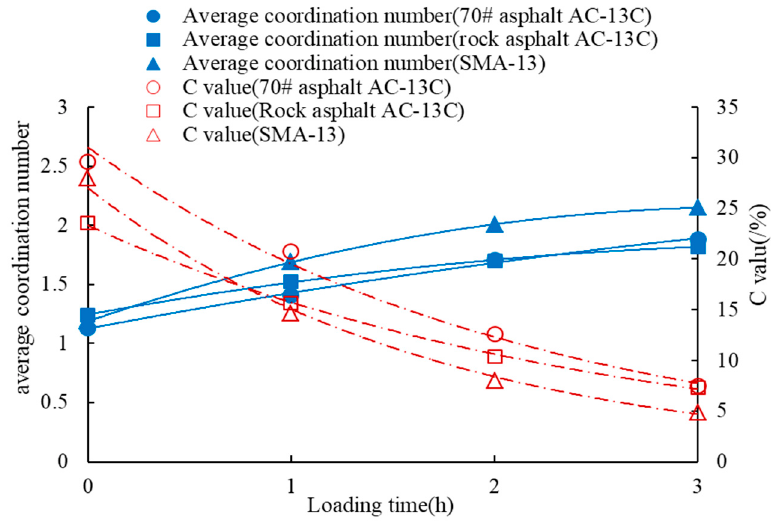
Figure 10. Gradual change trends of